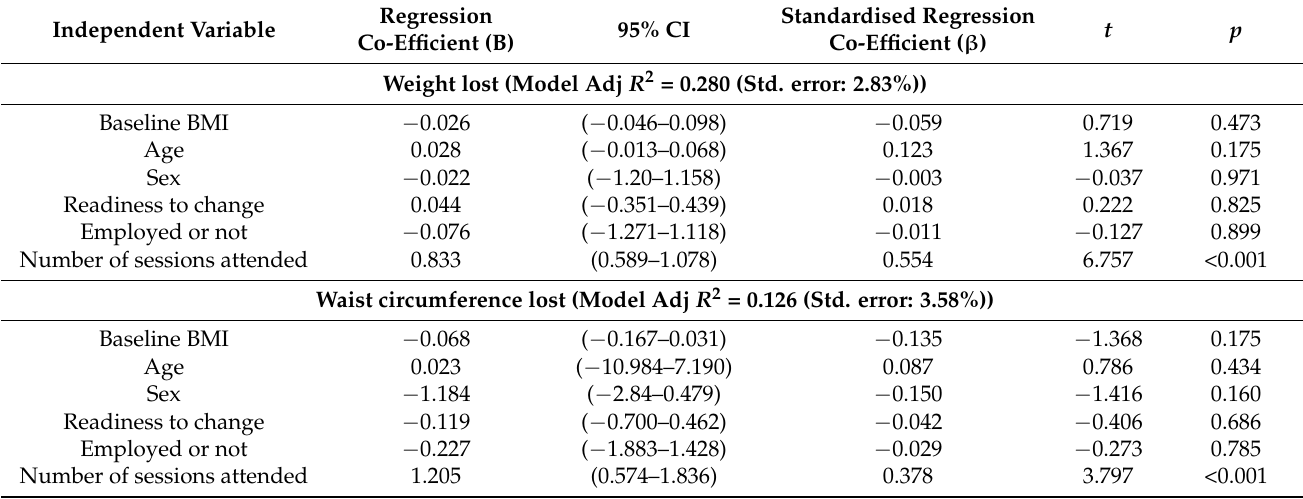
Table 3. Regression analyses of predictors of weight and waist